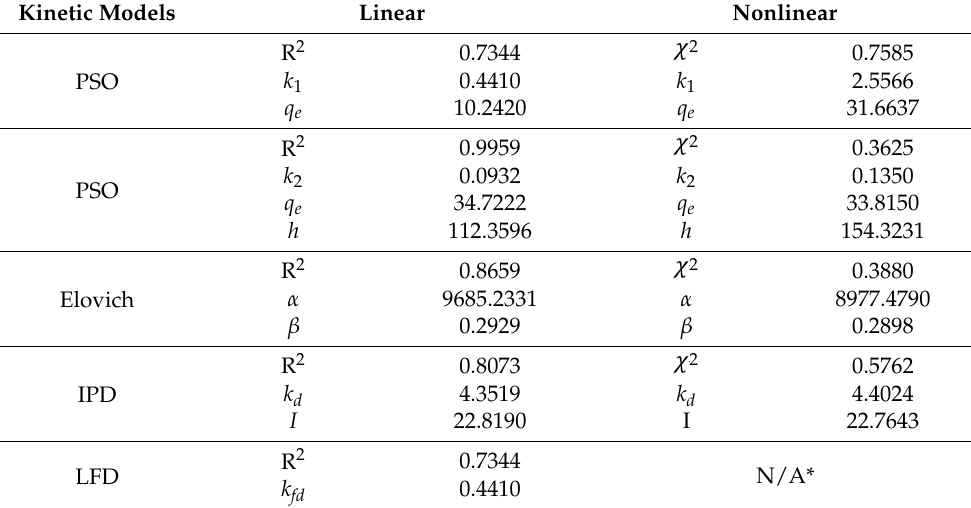
Table 4. Summary of kinetic model parameters from linear and nonlinear curve fitting of experimental data for motor oil-in-water sorption by CaSt 2 -KF.